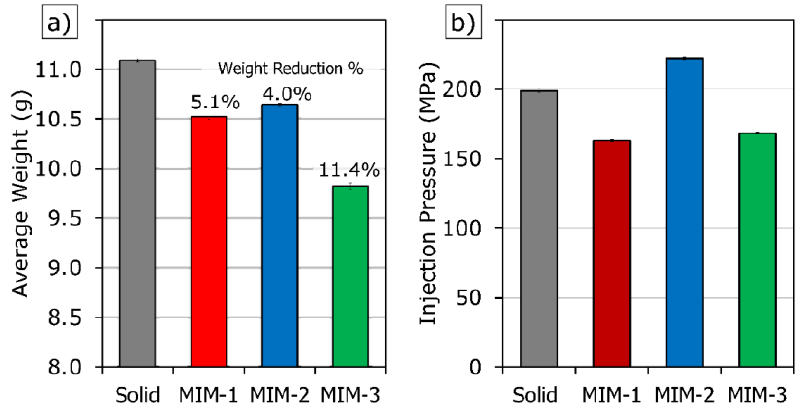
Figure 2. ( a ) Average part weight; ( b ) injection pressure values of tensile test bar samples.